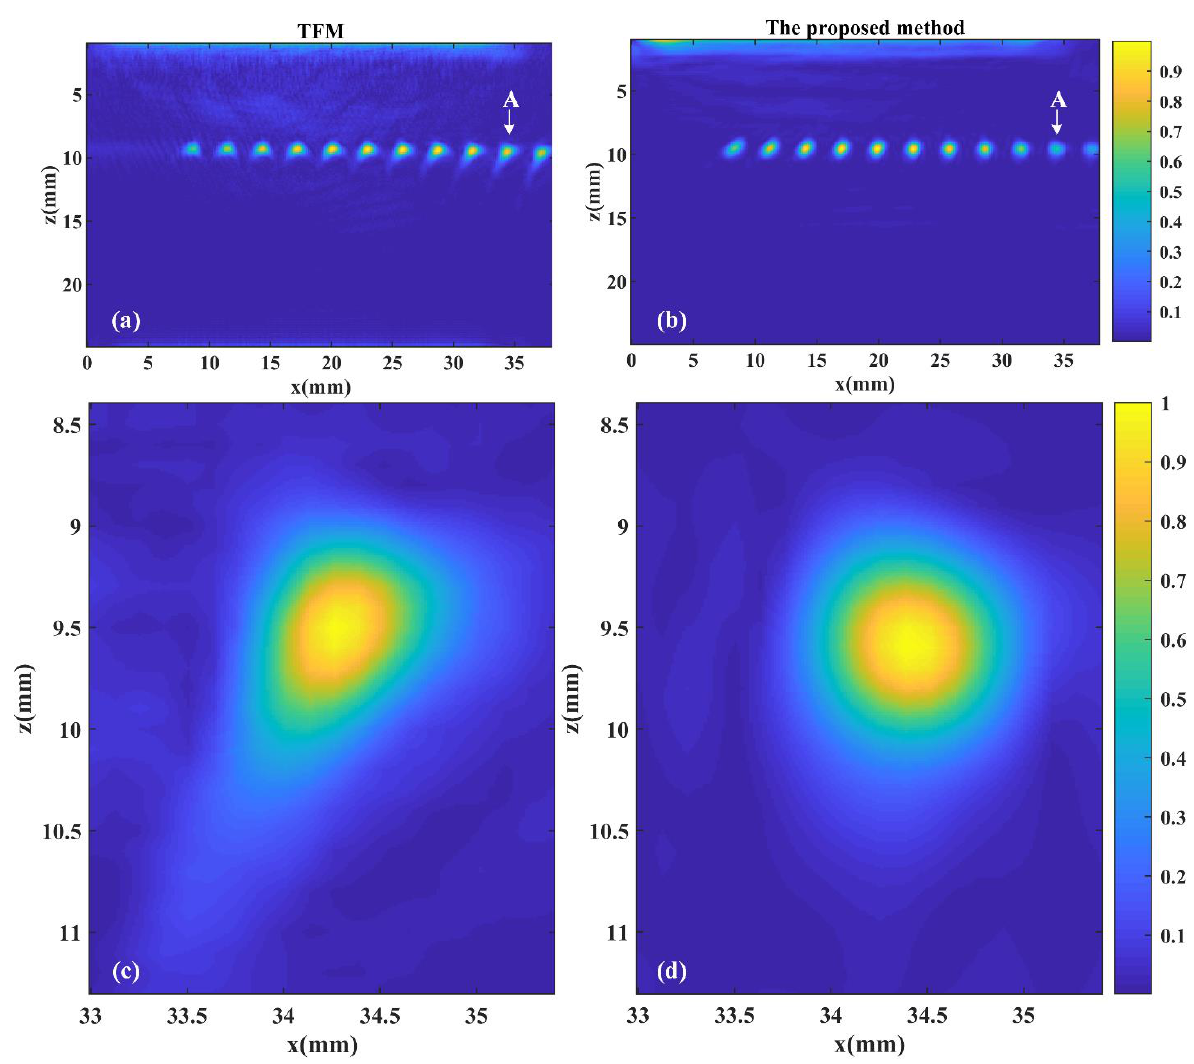
Figure 5. Simulation results reconstructed by TFM and proposed method. A in Figure 5a,b represents the imaging result of the tenth SDH of the specimen from left to right. ( a ) The image reconstructed by TFM. ( b ) The image reconstructed by the proposed method. ( c ) The local enlarged image of SDH A in Figure 5a. ( d ) The local enlarged image of SDH A in Figure 5b.